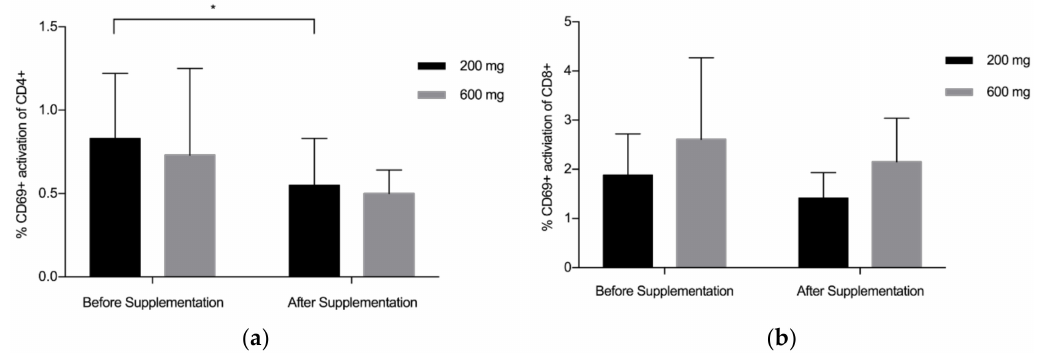
Figure 3. Pooled data from both Product A and B (200 mg, n = 12; 600 mg, n = 12). ( a ) Mean % CD69+ activation of CD4+ by dose of lactoferrin before and after supplementation; ( b ) Mean % CD69+ activation of CD8+ by dose of lactoferrin before and after supplementation. Bars indicate standard deviation. * p < 0.05.